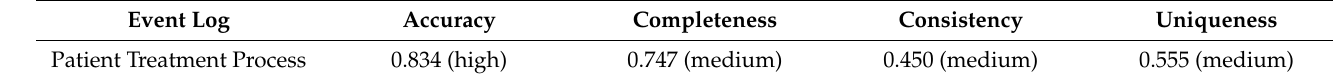
Table 5. Quality metrics calculated for patient admission event log